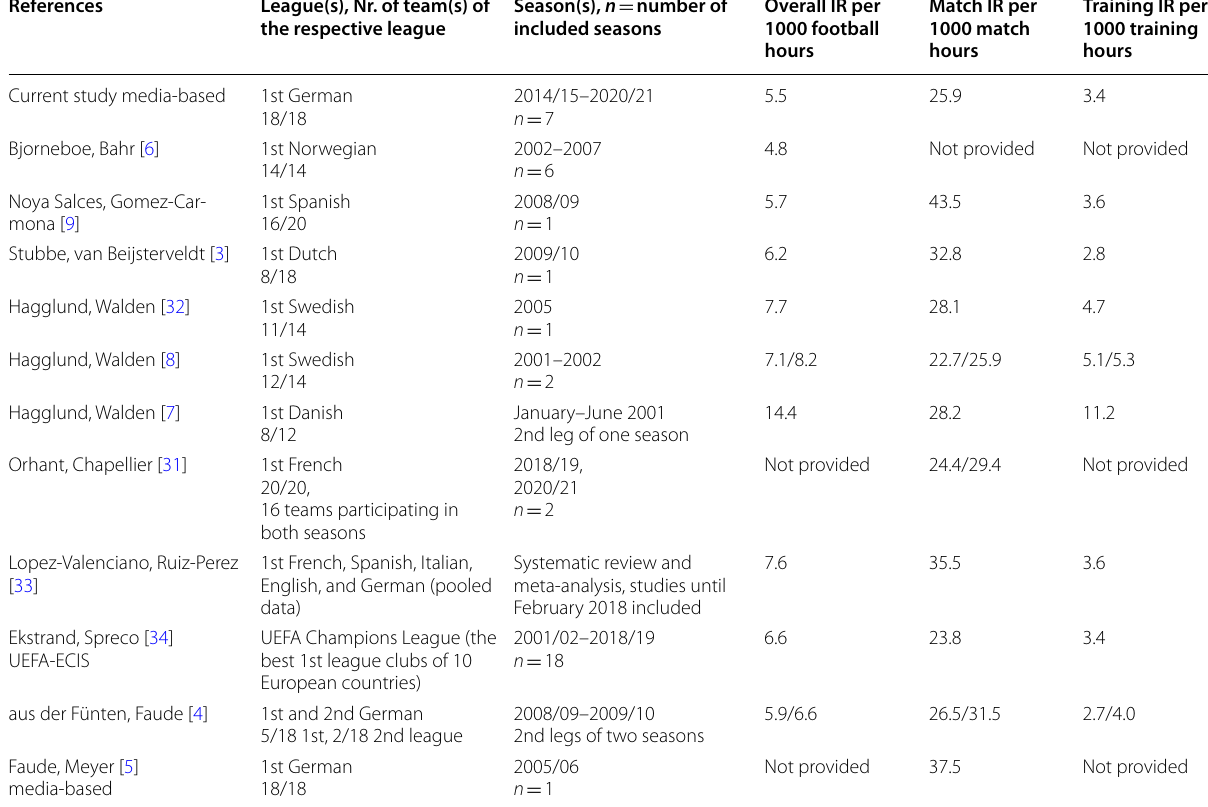
IR injury incidence rate; ECIS Elite Club Injury Study of the Union of European Football Associations